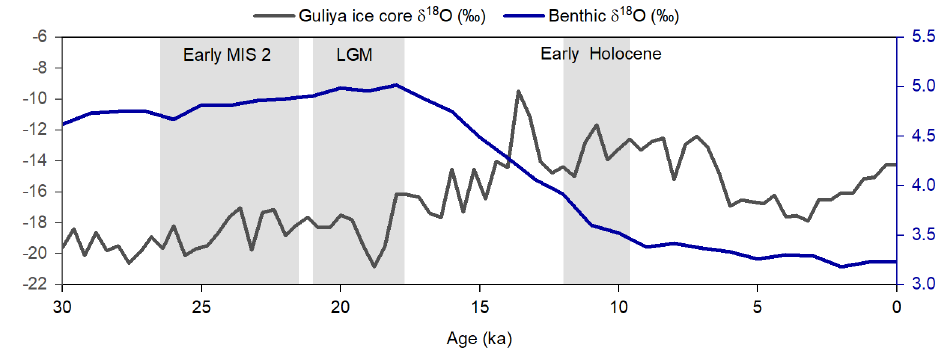
Figure 7. Guliya ice core [39] and Benthic δ 18 O records [35] since 30